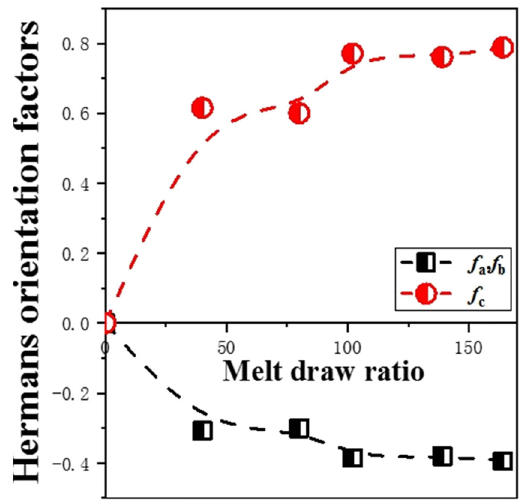
Figure 4: The Hermans ’ orientation degree of cast fi lms prepared at di ff erent MDRs.